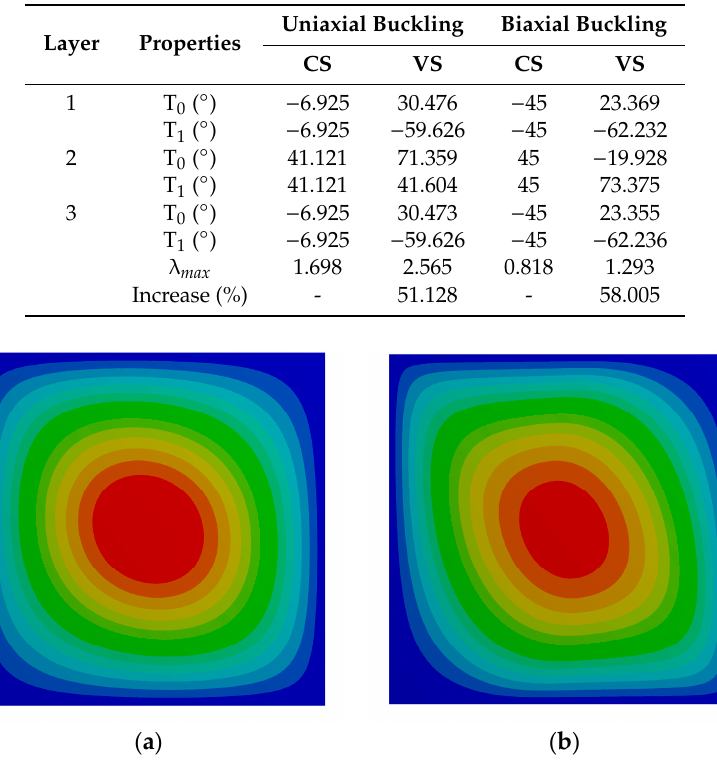
Table 20. Optimal angles of a three-layer VS plate for static buckling load multipliers.